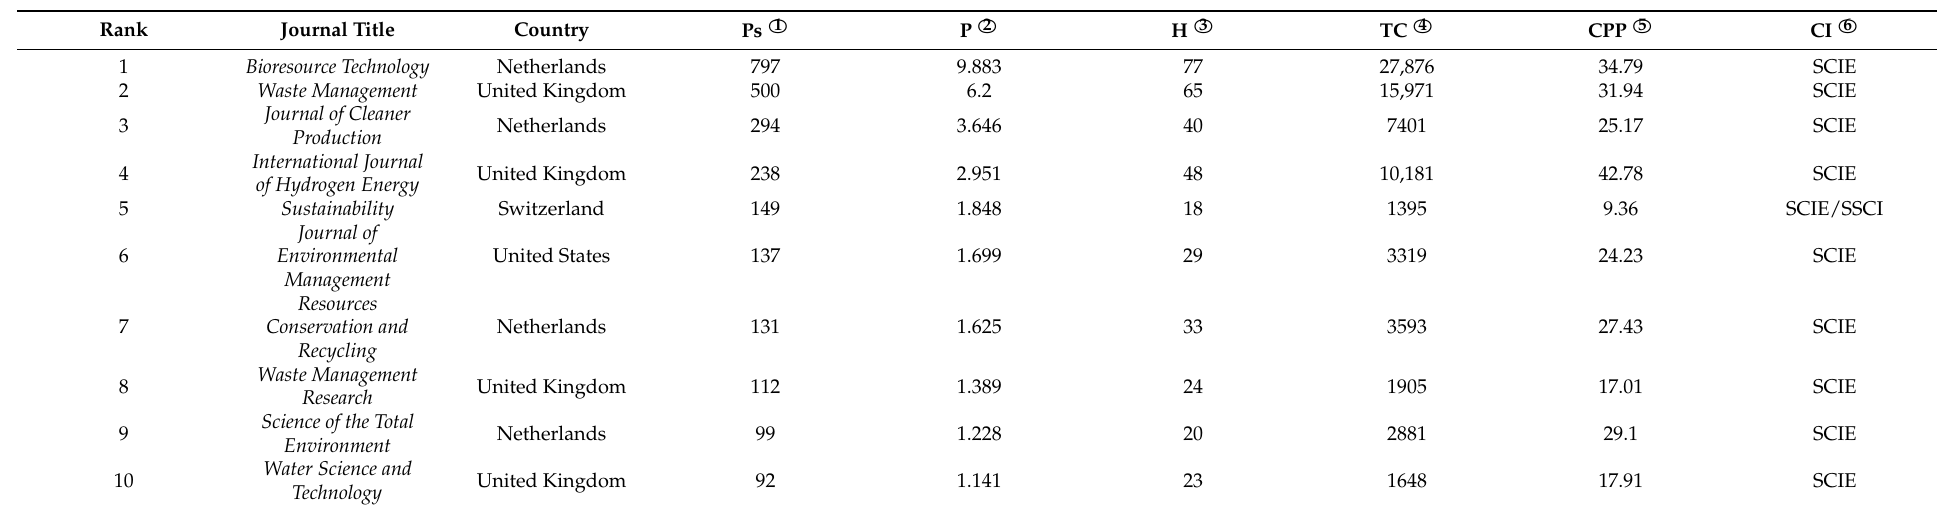
Table A3. Top 10 journals with the most publications in FW studies.